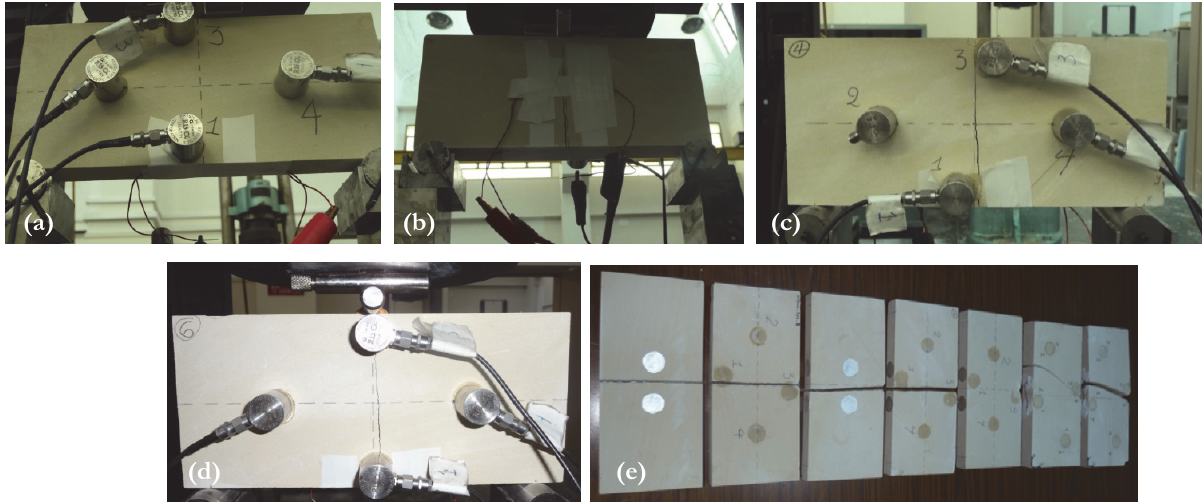
Figure 5: (a)-(d) Experimental set up for the Alfas stone specimens and the position of the AE sensors; (e) typical fractured